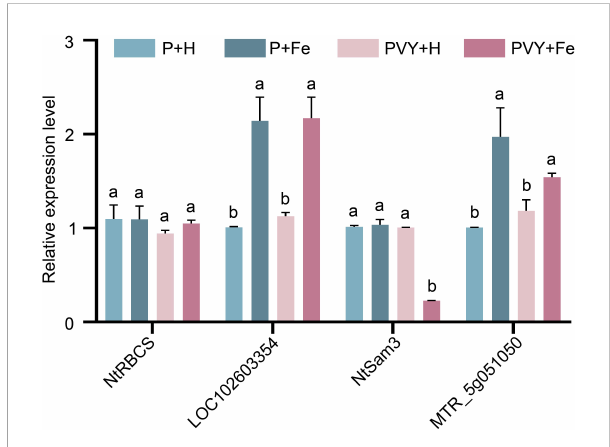
FIGURE 8 The expression levels of four genes determined by RT-qPCR under different treatments. Different lowercase letters indicate statistical difference between treatments. The statistical signi fi cances were determined using one-way analysis of variance followed by Duncan ’ s multiple comparison test ( P value <